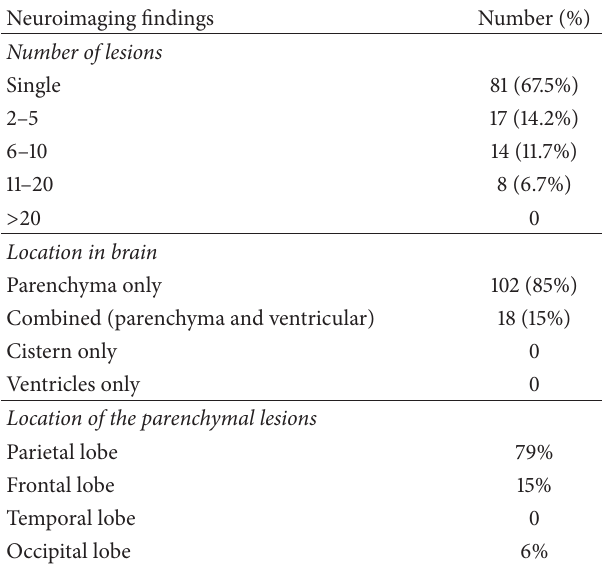
Table 2: Neuroimaging findings in children with NCC ( 𝑁 = 120 ). Table 3: Serum T solium antibodies by ELISA in children with neurocysticercosis ( 𝑁 = 43 ).